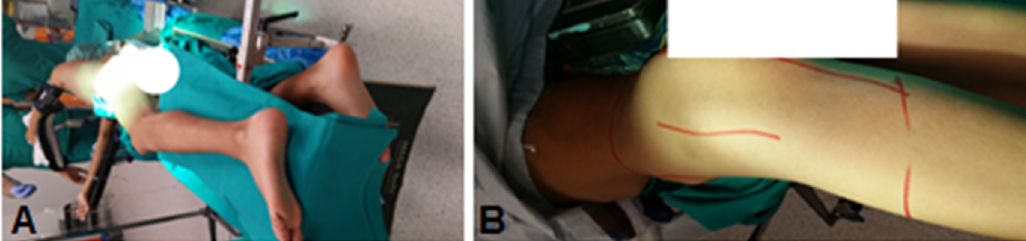
Figure 1. Patient position (A) and skin incision (B) in the Lt hip in patient No.